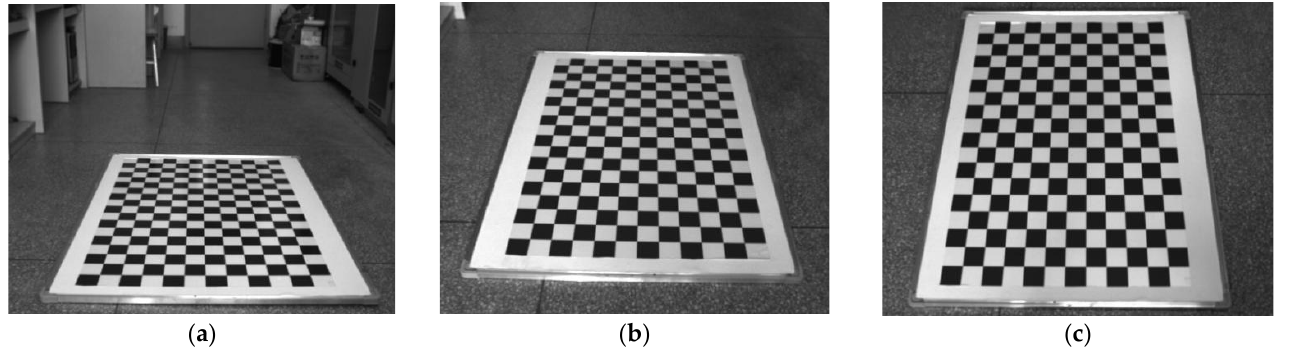
Figure 7. Calibration of eccentric angles under different shooting angles, showing ( a ) set 1, ( b ) set 2, and ( c ) set 3. Table 1. Calibration results of eccentric distances and camera elevation.